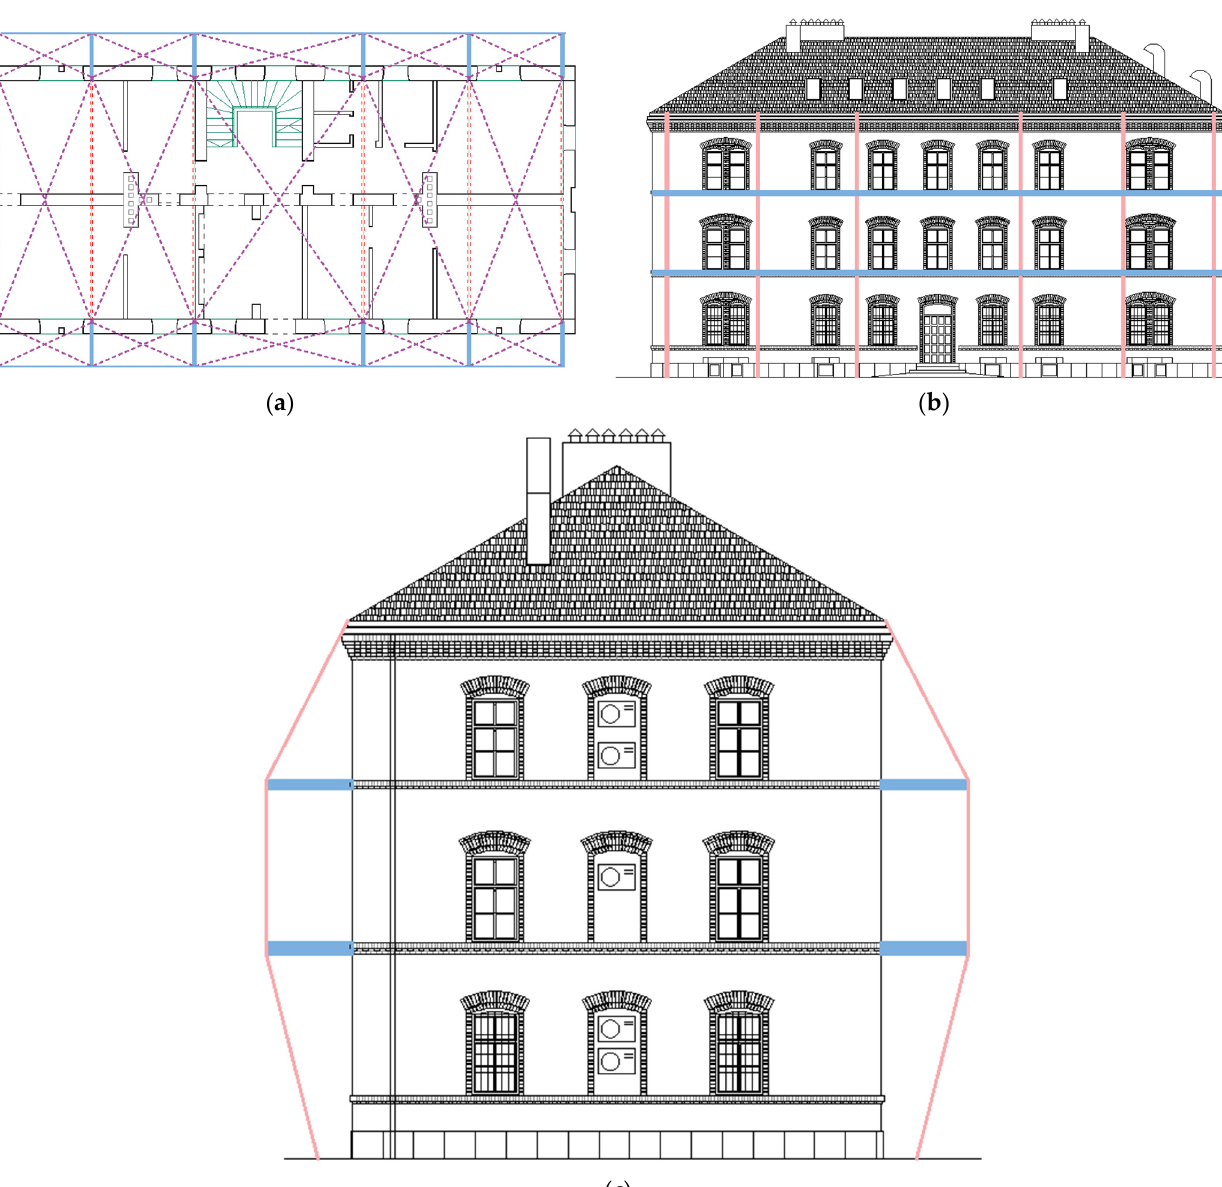
Figure 24. Alternative solution for the retrofitting: ( a ) ground floor plan; ( b ) longitudinal section; ( c ) transversal section.